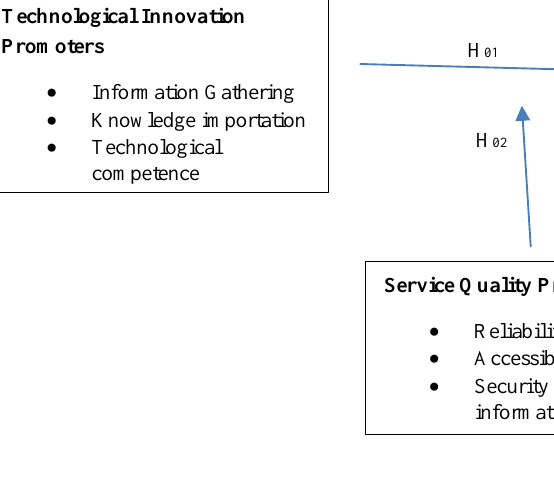
Figure 1: Hypothesized Conceptual